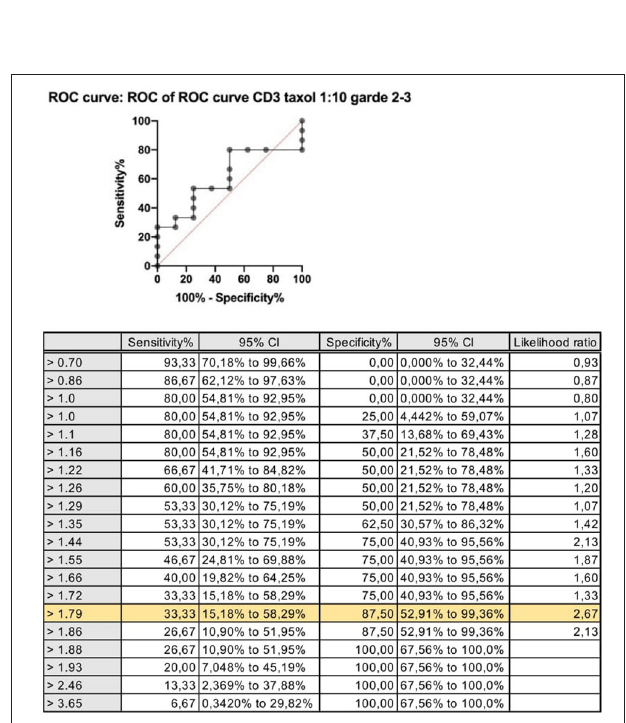
FIGURE 2 | ROC curve: stimulation index for CD63 expression after stimulation with paclitaxel 1:10 vs. saline CD63: Threshold > 1.8; sensitivity 33% and specificity